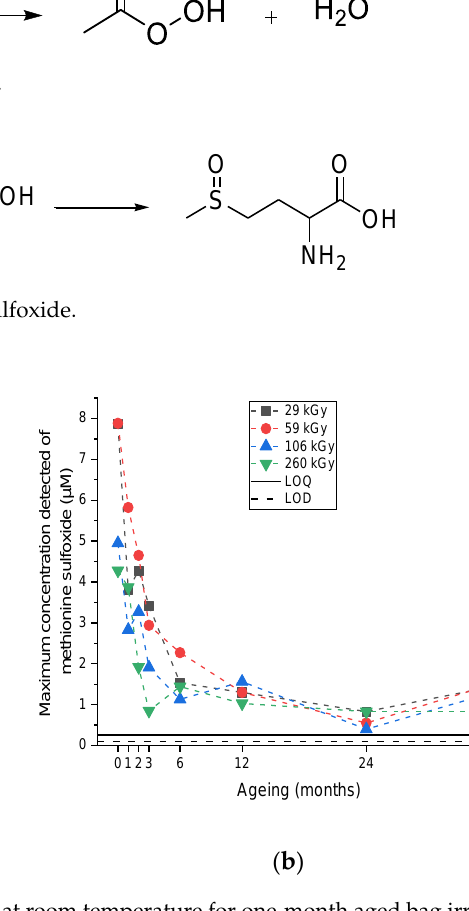
Scheme 4. Formation of methionine sulfoxide . Interestingly, the dose-dependence of the maximum concentration in methionine sul- foxide is not straightforward: the amount of methionine sulfoxide is larger for doses at 29 and 59 kGy than for doses at 106 and 260 kGy for bags aged less than six months (Figure 7b). Moreover, the oxidation level decreases with the ageing and is the same for all doses for ageing lasting more than six months. 4. Analysis at the Macromolecular Level The changes monitored and evidenced during mechanical tests, permeation, and acidity are investigated at the macromolecular scale. That is, structural modificationsat surface, crystallinity, oxidation, thermal stability are investigated using different tech- niques such as FTIR, µ-ATR, XPS, DSC, combined with PCA and AComDim as chemo- metric techniques for analysis. 4.1. Crystallinity While it is possible to observe cross-linking events through the mechanical tests, FTIR analysis is not sensitive enough to detect their occurrence. The signals of the -CH 2 - and - CH 3 groups are not modified, as highlighted in Figure 8: at 2916 and 2848 cm −1 for the asymmetric and symmetric stretching vibrations of the -CH 2 - group, respectively. The bands at 1474 and 730 cm −1 correspond to the crystalline phase and the bands at 1464 and